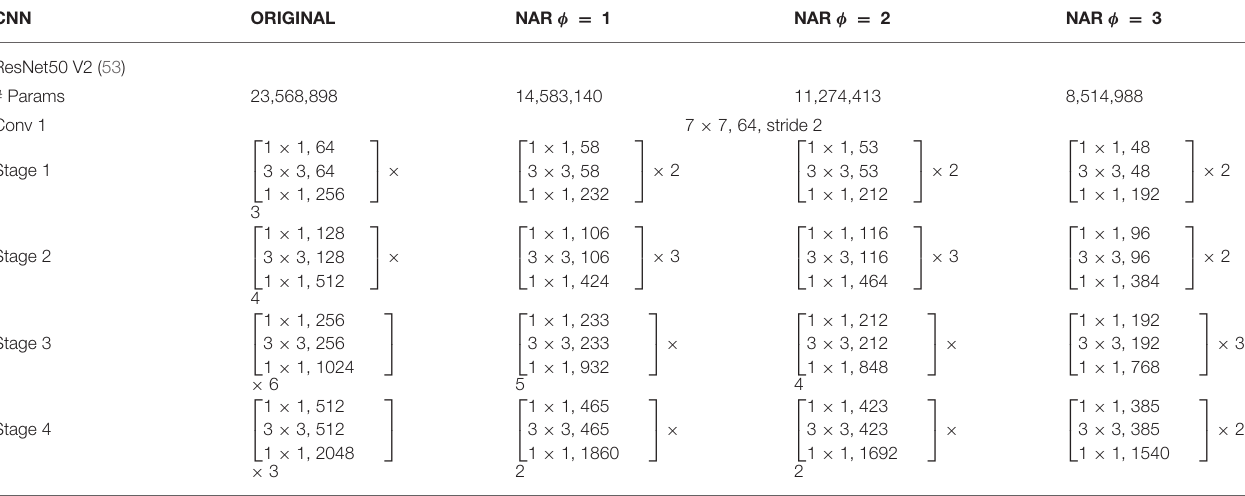
TABLE 1 | Number of parameters and layers organization in original ResNet50 V2 and NAR simplified